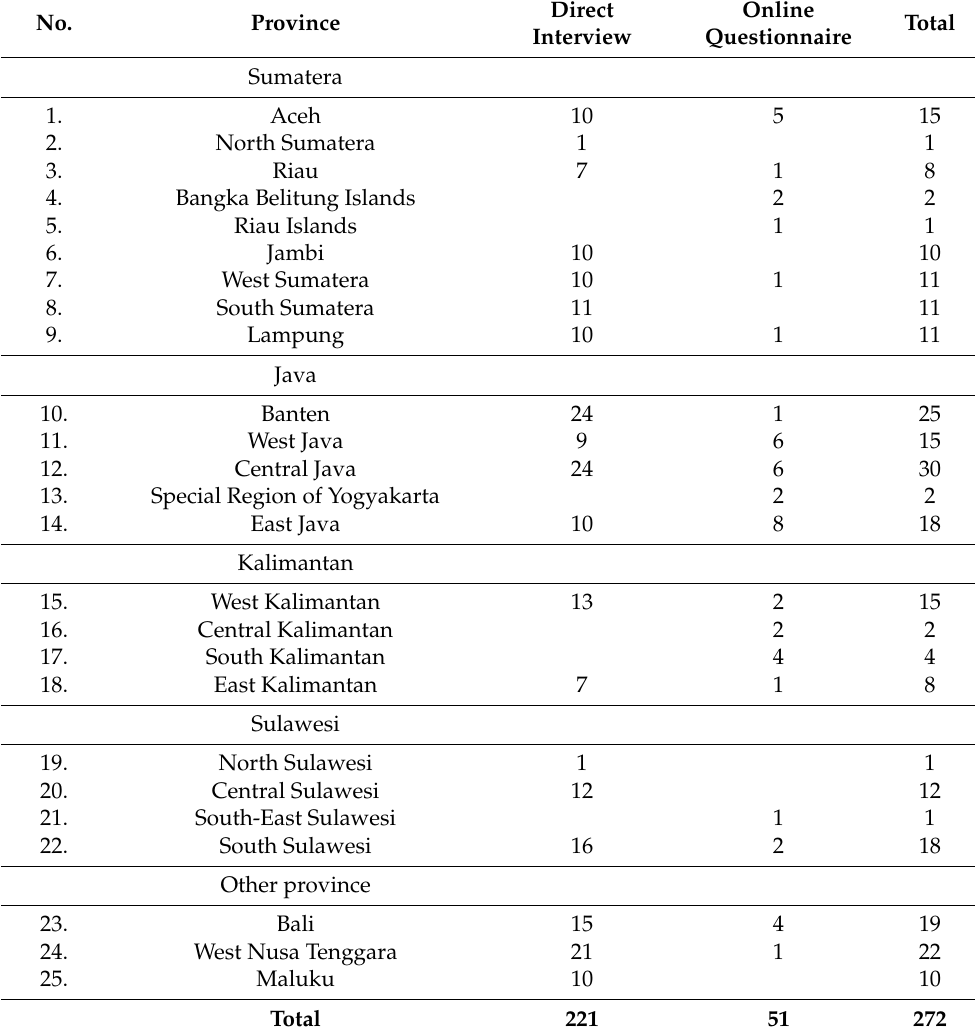
Table 1. Selected region and number of beekeepers per